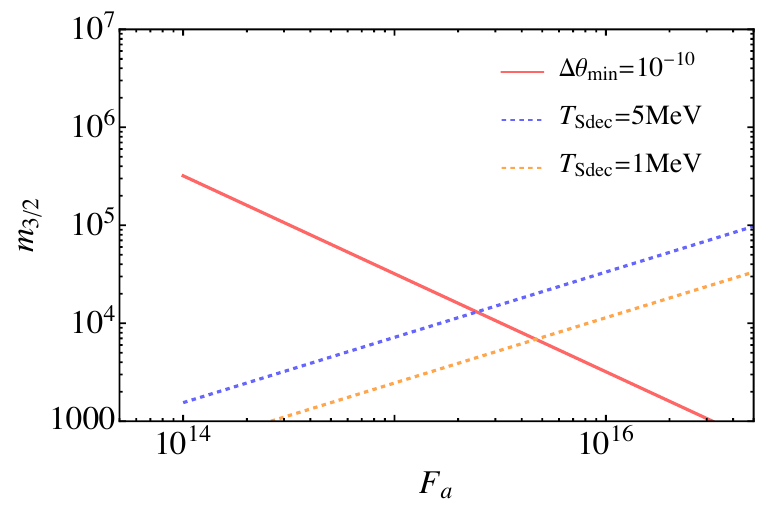
) (1) satisfying ∆¯ θ = 10 − 10 (red min 3 / 2 = 5MeV (blue dashed) and 1MeV (yellow dashed) S dec and T min S dec